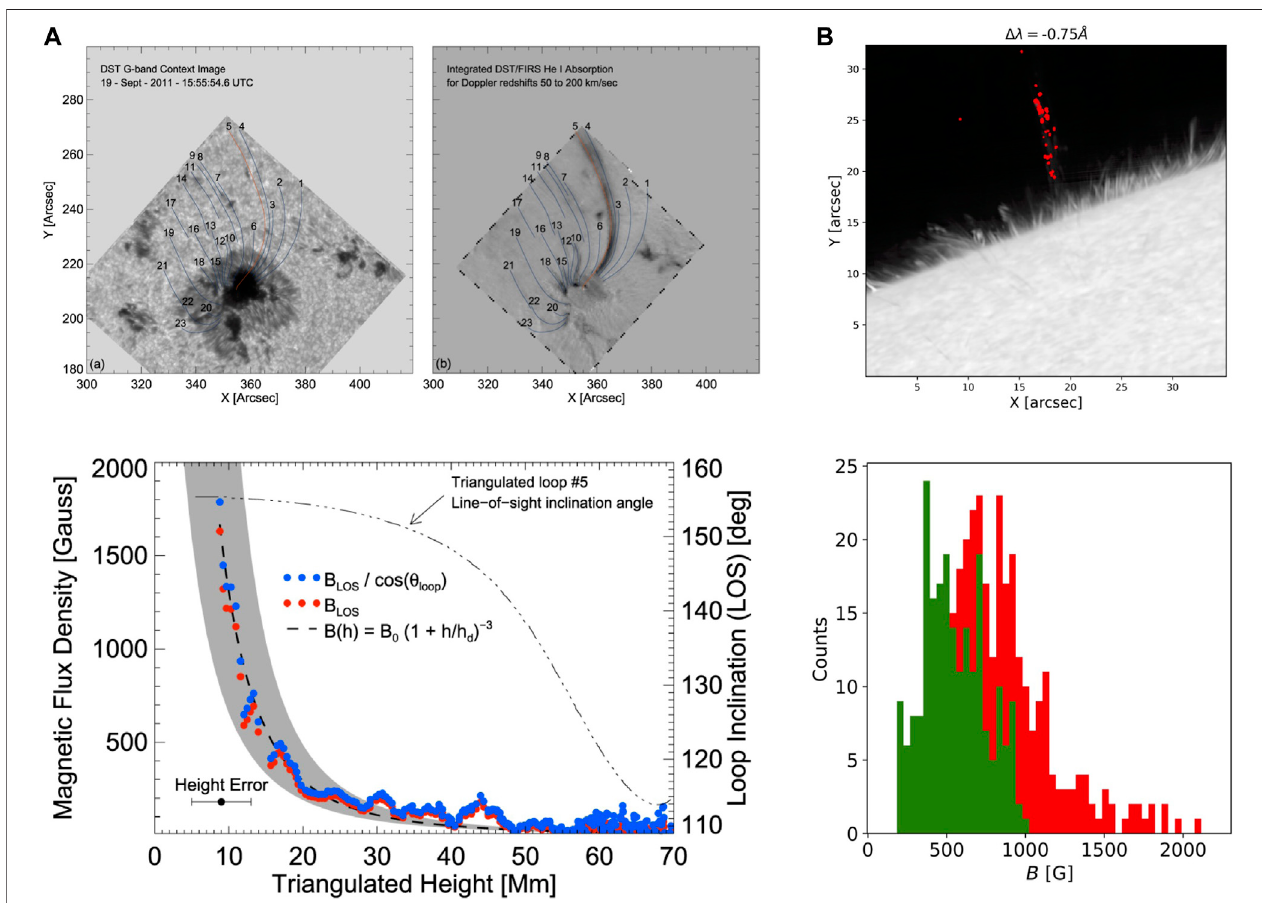
FIGURE 18 | Magnetic fi eld measurements from coronal rain observations. (A) the 2 panels on top show coronal rain (likely of the hybrid kind) detected in the He I 10830 line with DST /FIRS, continuously falling along a coronal loop onto a sunspot umbra, reported by Schad et al. (2016) (Figures 3 and 8 of that paper © AAS. Reproduced with permission). Spectropolarimetry isperformed to inferthe coronal magnetic fl ux along theloop with respect tothe triangulated height (LOS component inred,totalcomponentinblueinferredfromthemeasured inclinationoftheloopthroughtriangulation). (B) SST observationsintheCaII8542line(toppanelshows the spectral position shifted − 0.75 Å from linecentre) of quiescent coronal rain at the limb, reported by Kriginsky et al. (2021) (Figures 4 and 9 of that paper, reproduced withpermission©ESO).RedpointsoverlaidonthetoppaneldenotelocationswheretheWFAmethodwassuccessfullyappliedtoinfertheLOSmagnetic fi eld.Thetotal magnetic fi elddistribution isshowninthebottom,calculatedusingtheloopinclinationderivedfromthePOStoLOSvelocityratio.Thegreenandredhistograms denote, respectively, the measurements for which the Zeeman width is lower and higher than the Doppler width. Note that the WFA condition formally applies in the former case (green histogram). See the text and the respective papers for further